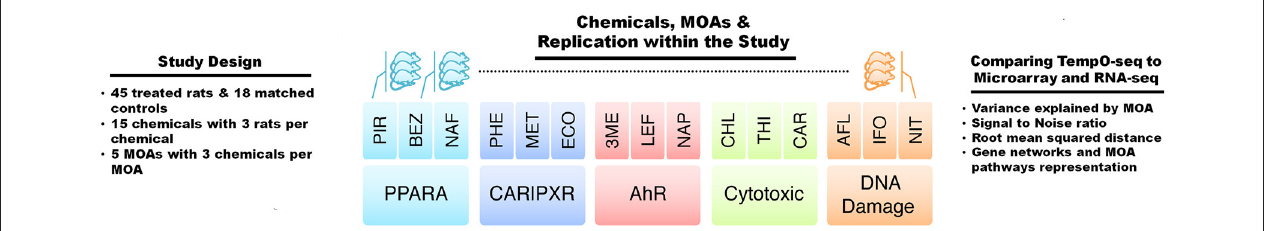
FIGURE 1 | Study design. The study comprised of gene expression data acquired from male Sprague-Dawley rats dosed once daily in triplicate for 3, 5, or 7 days depending on the test chemical or matched control, and livers were harvested 24h after the last dose. The abbreviations for the names of the chemicals are listed in Table 1 . There were five modes of action (MOAs) with three chemicals per MOA. The MOAs are PPARA, peroxisome proliferator-activated receptor alpha; CAR/PXR, orphan nuclear hormone receptors; AhR, aryl hydrocarbon receptor; Cytotoxic, cytotoxicity, and DNA Damage. Comparisons between the data from TempO-Seq to microarray and RNA-Seq were performed by statistical and bioinformatics methodologies.